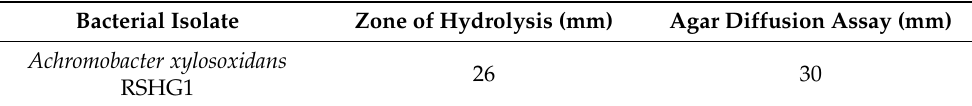
Table 1. Screening of bacterial isolate for glutaminase production by zone of hydrolysis.